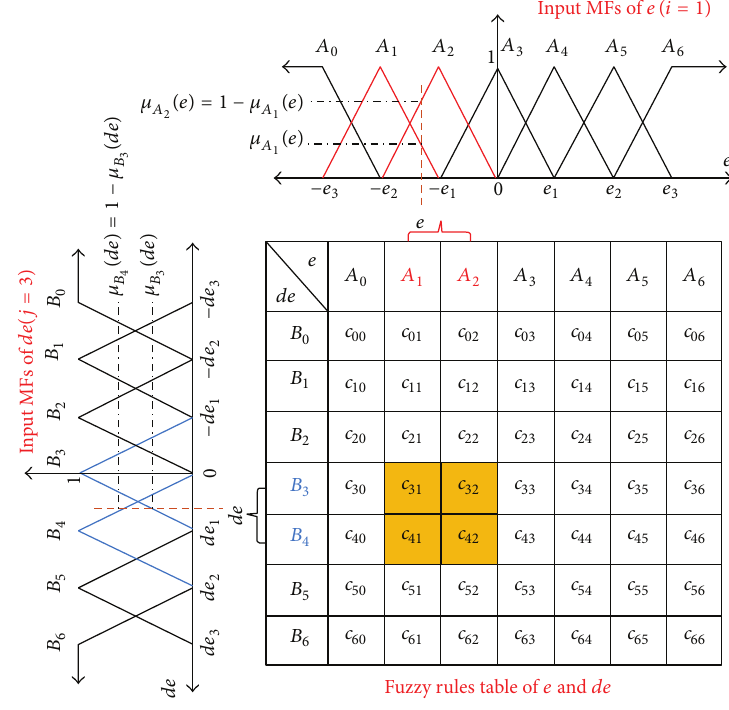
Figure 10: The membership functions of 𝑒 , 𝑑𝑒 , and fuzzy rule